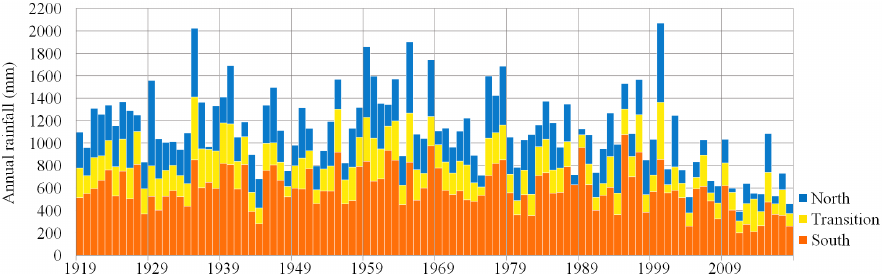
Figure 8. Annual rainfall from 1919–2019 at each of the climatic regions averaged out of the total 126 grid-point rainfall series clustered from the factor analysis, i.e., at the north (54 centroids), transition (20 centroids) and south (52